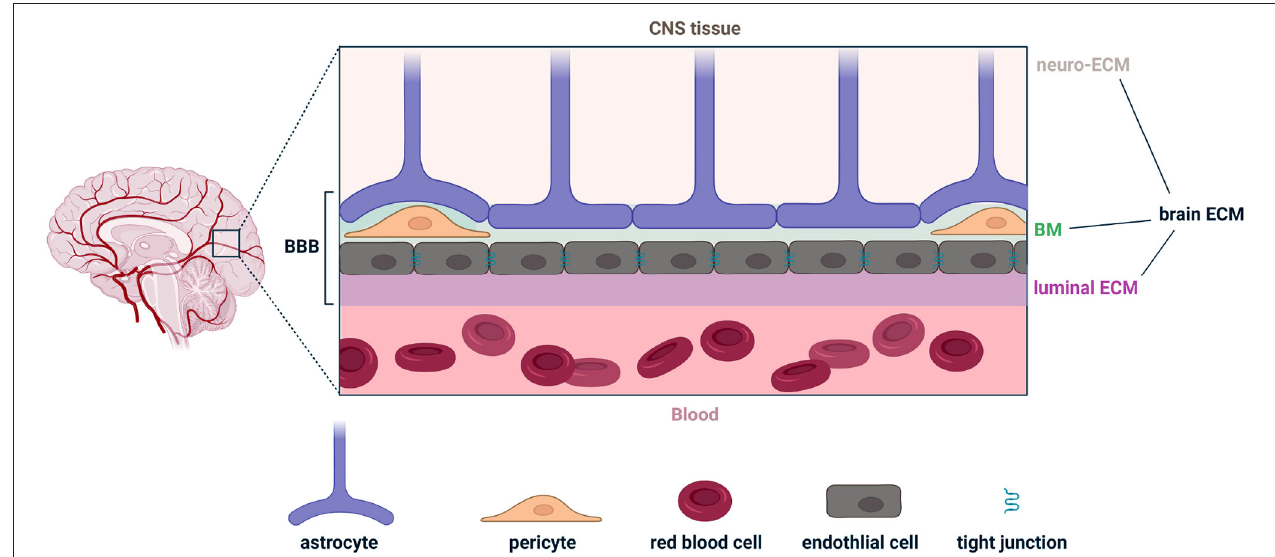
FIGURE 1 | Illustration of the various components comprising the brain extracellular matrix (brain ECM) and the blood-brain barrier (BBB). The brain ECM is the combination of the ECM in the central nervous system (neuro-ECM), the basement membrane (BM), and the luminal ECM (also called the glycocalyx). The BBB is the combination of the BM, luminal ECM, and astrocytes, pericytes, and endothelial cells. Figure made with